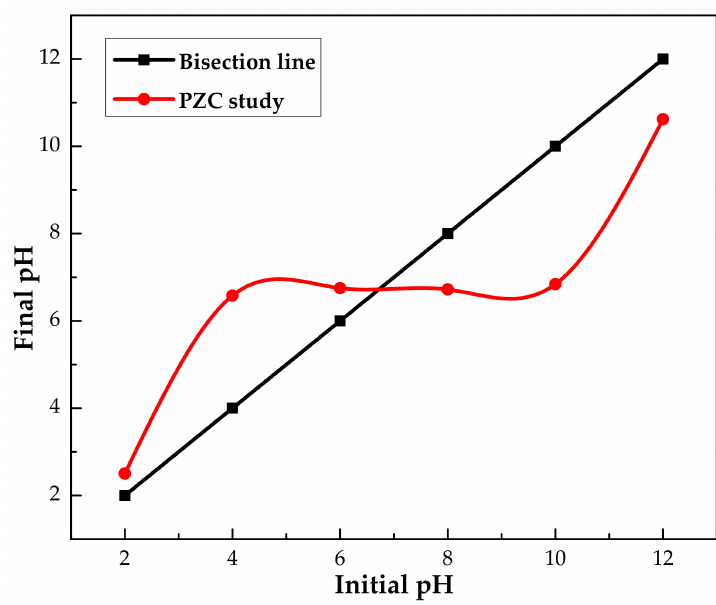
Figure 7. pH pzc analysis of agar–alginate-IL beads study at room temperature.